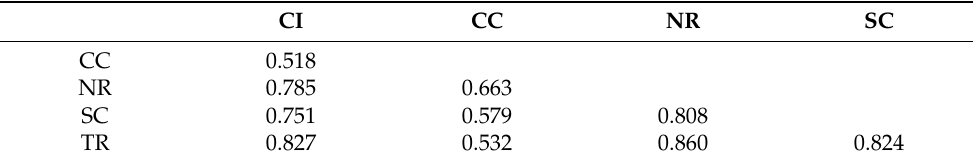
Table 3. Heterotrait-monotrait ratio (HTMT).